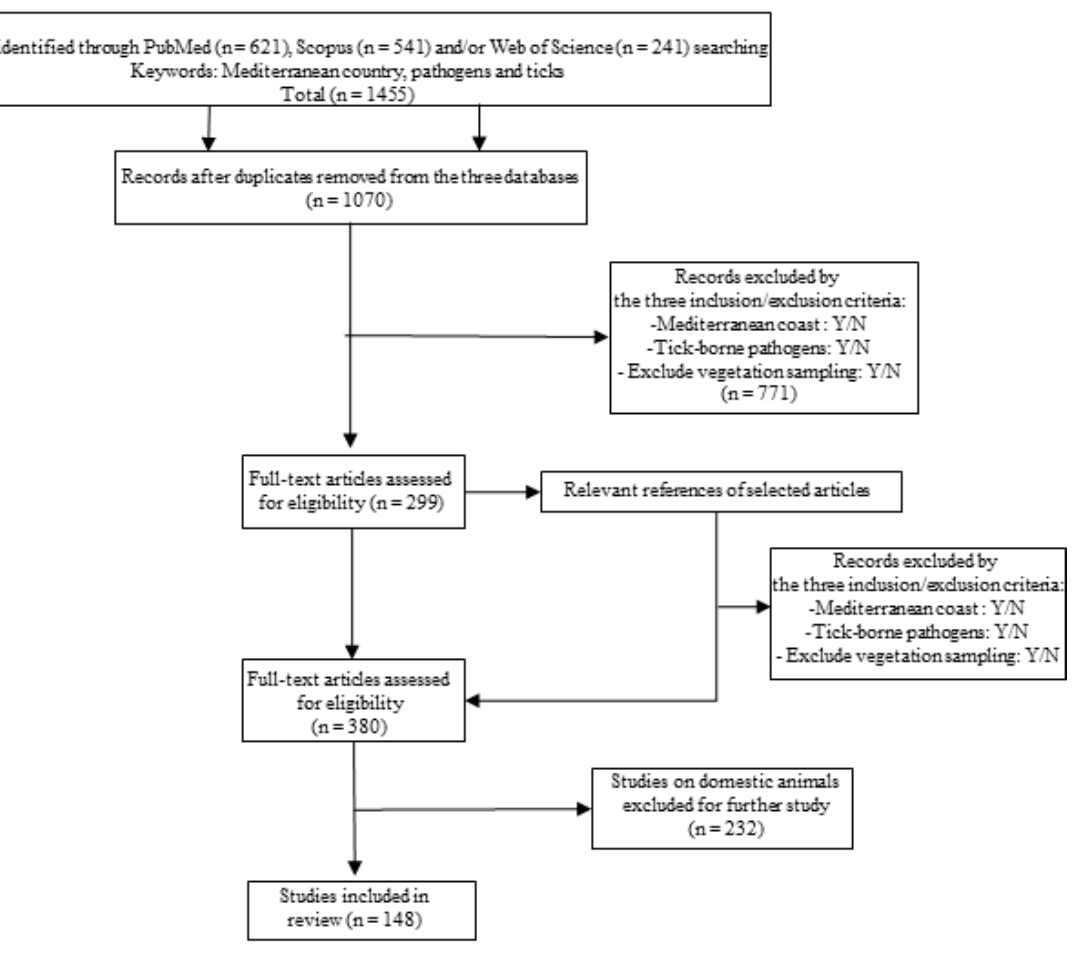
Figure 1. Methodology diagram for the bibliographic research in keeping with the PRISMA 2009 flow chart according to Moher et al., 2015.